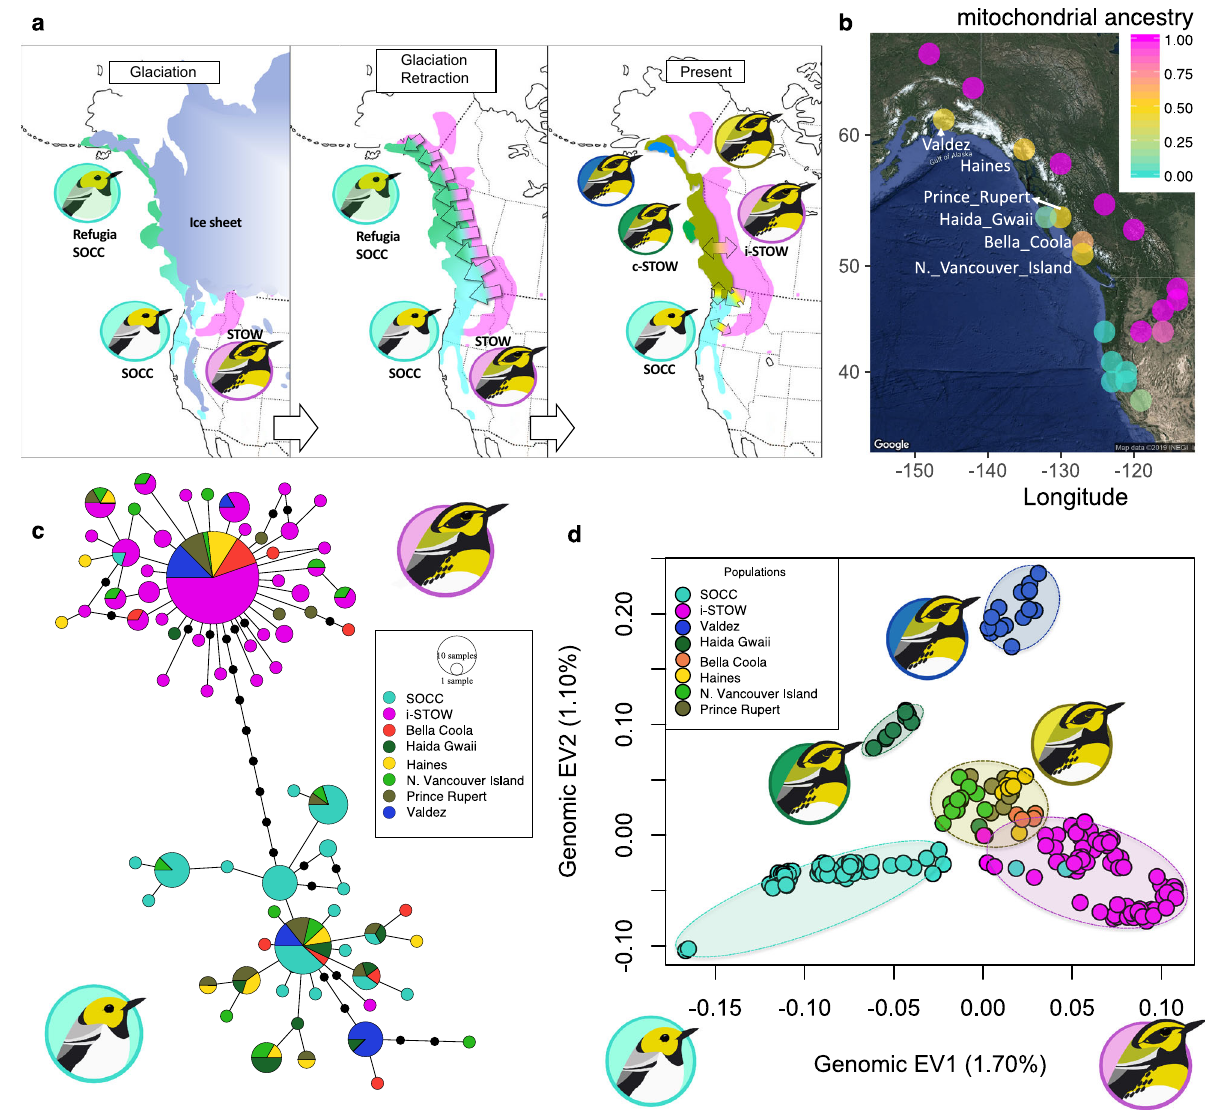
Fig. 1 Coastal populations of S. townsendi (coastal STOW) demonstrate a mixture of mitochondrial and nuclear ancestry from S. occidentalis (SOCC) and inland S. townsendi (i-STOW). a Illustration of the inferred history of differentiation and hybridization between STOW and SOCC during glacial expansion and retraction 29 . Left: During the last glacial maxima, the SOCC and STOW populations resided in isolated glacial refugia. Center: after glacial retraction, the refugial SOCC and inland STOW expanded and hybridized along a broad inland-to-coastal front parallel to the coast. Right: the historical hybridization resulted in coastal STOW populations with admixed ancestry although the plumage resembles that of inland STOW. Population substructure within coastal STOW could be a result of refugial isolation. At present, most of the coastal STOW are not isolated from inland STOW by physical barriers. Map data ©2019 Google. Glacial reconstruction illustrations by Silu Wang. b Map data ©2019 Google. Mitochondrial ancestry of across sampling site, with colour representing the proportion of individuals belonging to the two major clades shown in: c Haplotype network of mitochondrial ND2 gene sequences from ref. 29 , with colours representing sampling sites 29 (red for Bella Coola, forest green for Haida Gwaii, yellow for Haines, light green for North Vancouver Island, army brown for Prince Rupert, royal blue for Valdez). Each circle represents a haplotype and area of the circles are proportional to the number of individuals carrying each haplotype. The lines (regardless of their lengths) between the circles represent one mutation between haplotypes, the black dots on the lines represent additional mutations among haplotypes. SOCC and inland STOW almost universally belong to divergent mtDNA clades, whereas coastal STOW populations harbor a mixture of these two major clades. d Principle component analysis of covariance with 222,559 SNPs in the nuclear genome. Coastal STOW are intermediate in Eigenvector (EV) 1 but distinct from inland STOW and SOCC in EV2. EV1 represents inland STOW vs SOCC differentiation. Three distinct coastal STOW clusters are evident: Valdez (royal blue), Haida Gwaii (forest green), and other coastal STOW (thereafter abbreviated as oc-STOW, army brown circling gold). Bird illustrations by Gil Jorge Barros